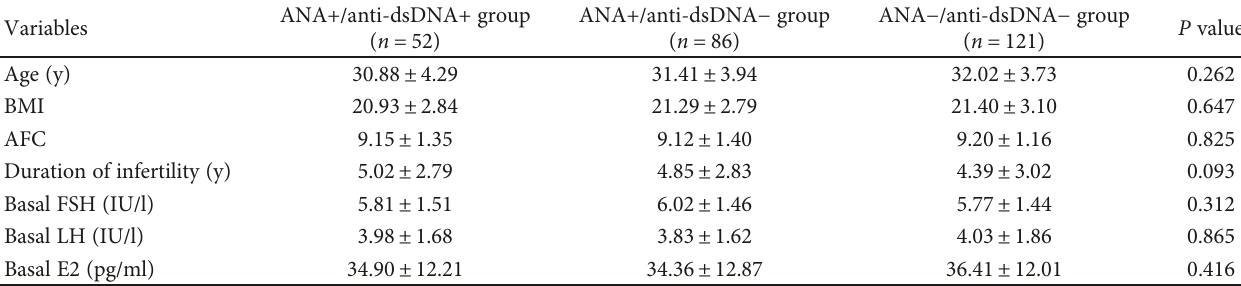
Table 1: General characteristics among the three groups in the IVF cycle.